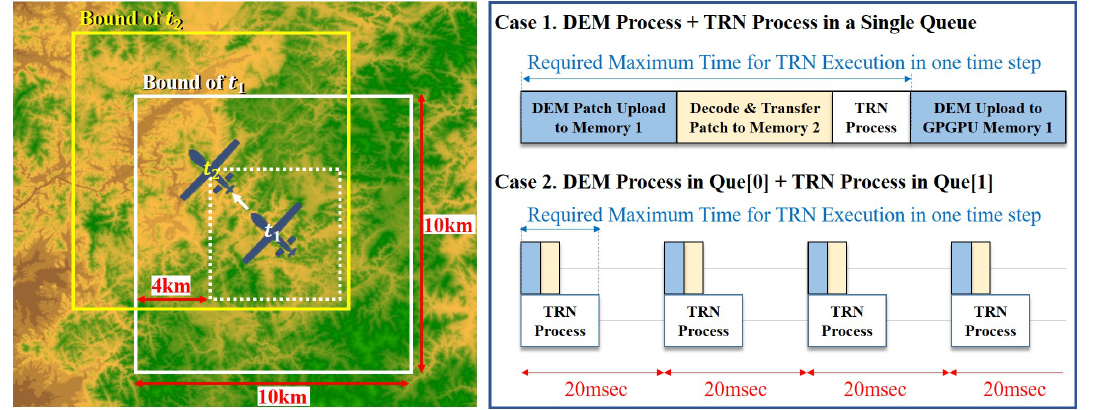
Figure 5. Transmission scheme of the high resolution DEM information